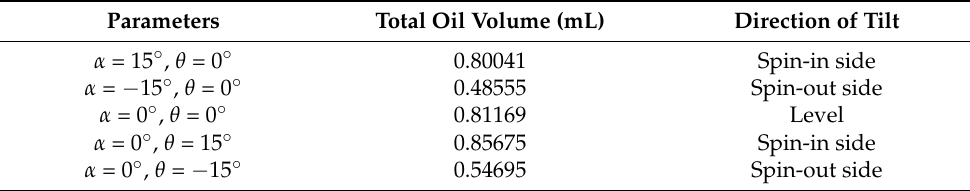
Table 3. Total oil quantity at different flight attitudes (Monitoring Surface